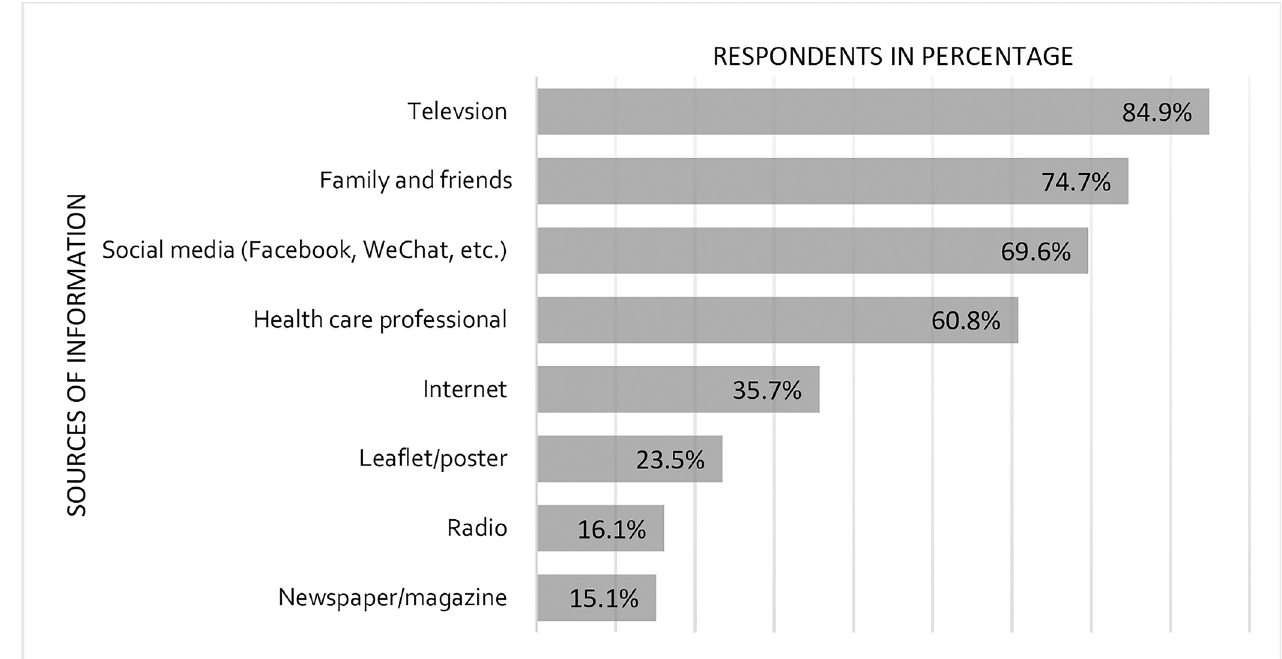
Fig 1. Sources of information among respondents of the knowledge, attitude and practices on COVID-19 preventive measures survey in Bhutan, January–February,